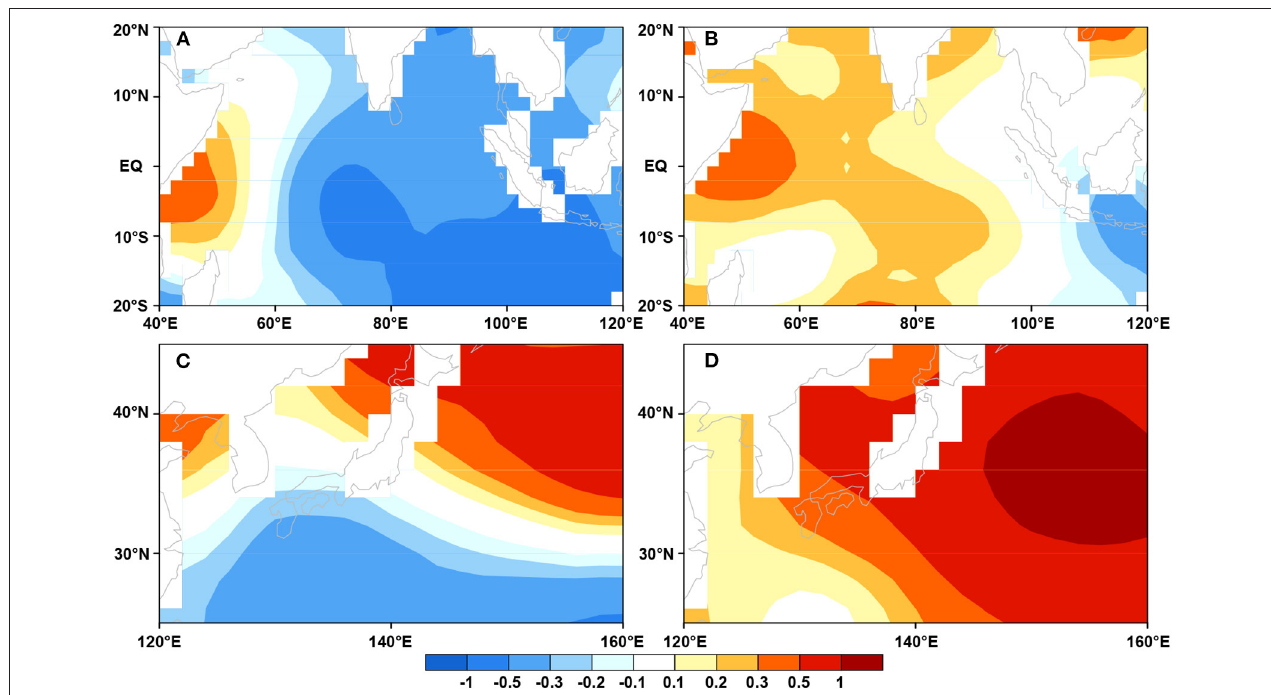
FIGURE 5 | Distributions of early summer SSTA average (units: ◦ C) of extreme years over (A,B) tropical IO and (C,D) the Kuroshio area in the cold period (A,C) and the warm period (B,D)